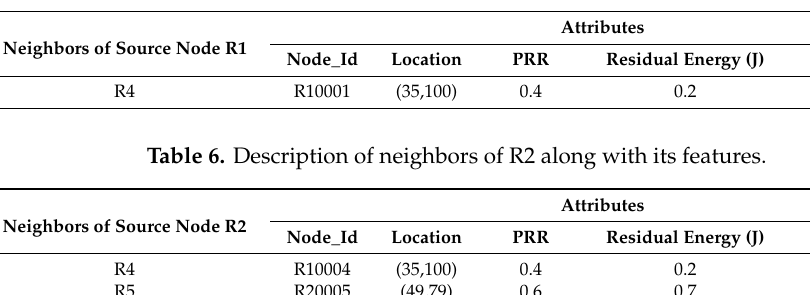
Table 5. Description of neighbors R1 along with its features.